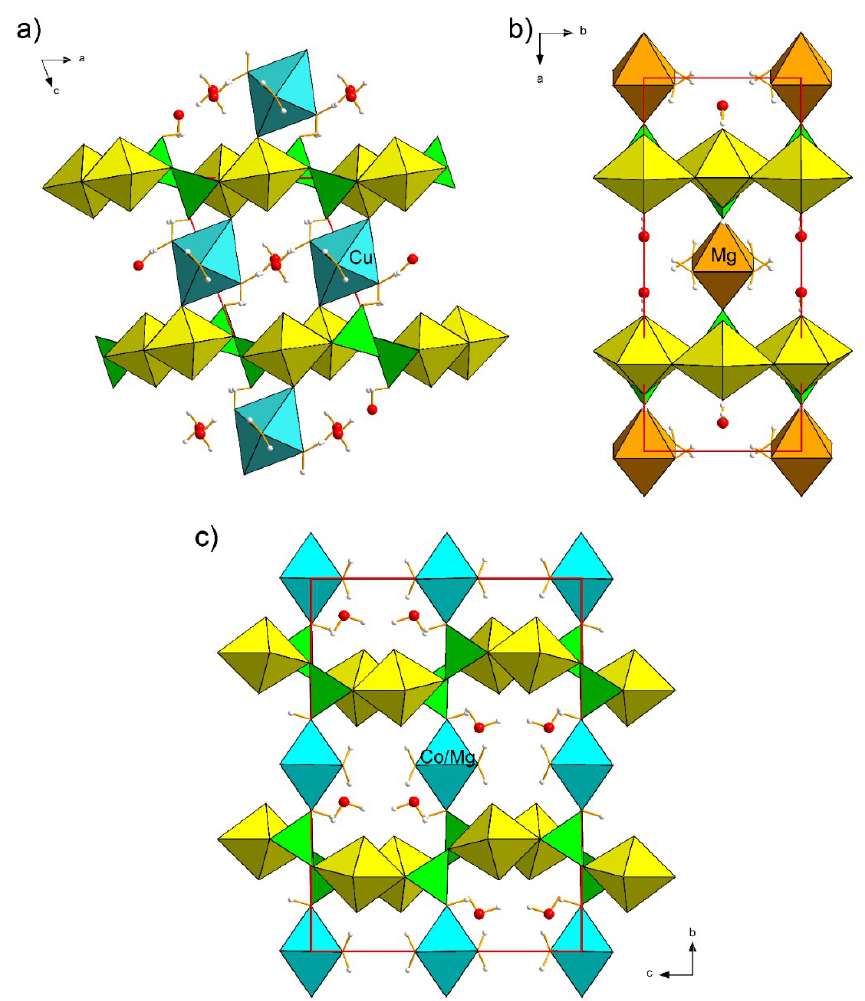
Figure 4. Crystal structures of minerals of the uranophane group (including H atoms). ( a ) Cuprosklodowskite. ( b ) Sklodowskite. ( c ) Oursinite. UO 7 bipyramids are in yellow; SiO 4 tetrahedra are in green, O atoms of the H 2 O groups are in red, unit-cell edges outlined as red solid-lines.